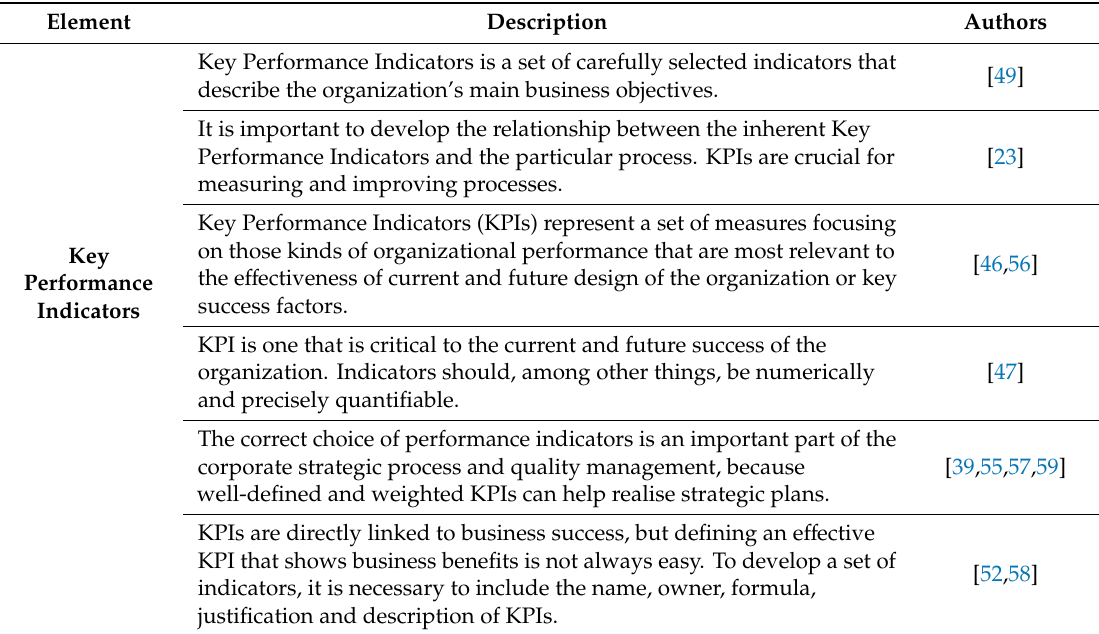
Table 5. The term, key performance indicators, used in relation to organizational performance.